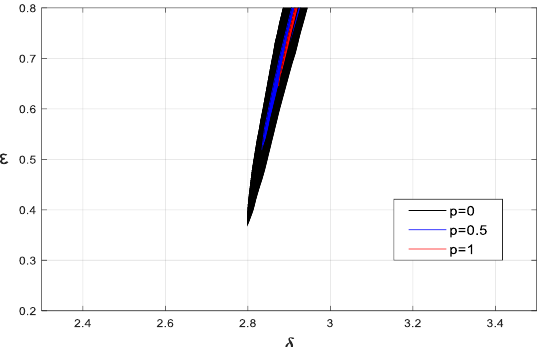
Figure 21. The effects of p on the 6T -resonance